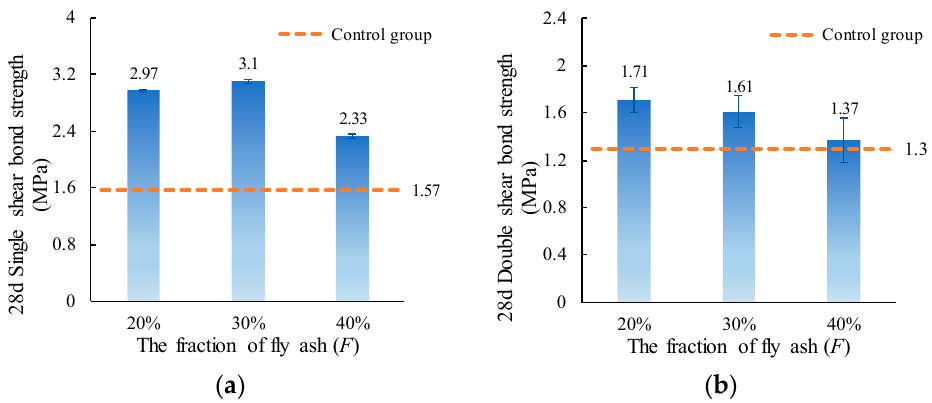
Figure 8. ( a ) Single shear bond strength and ( b ) double shear bond strength of specimens with varying F .